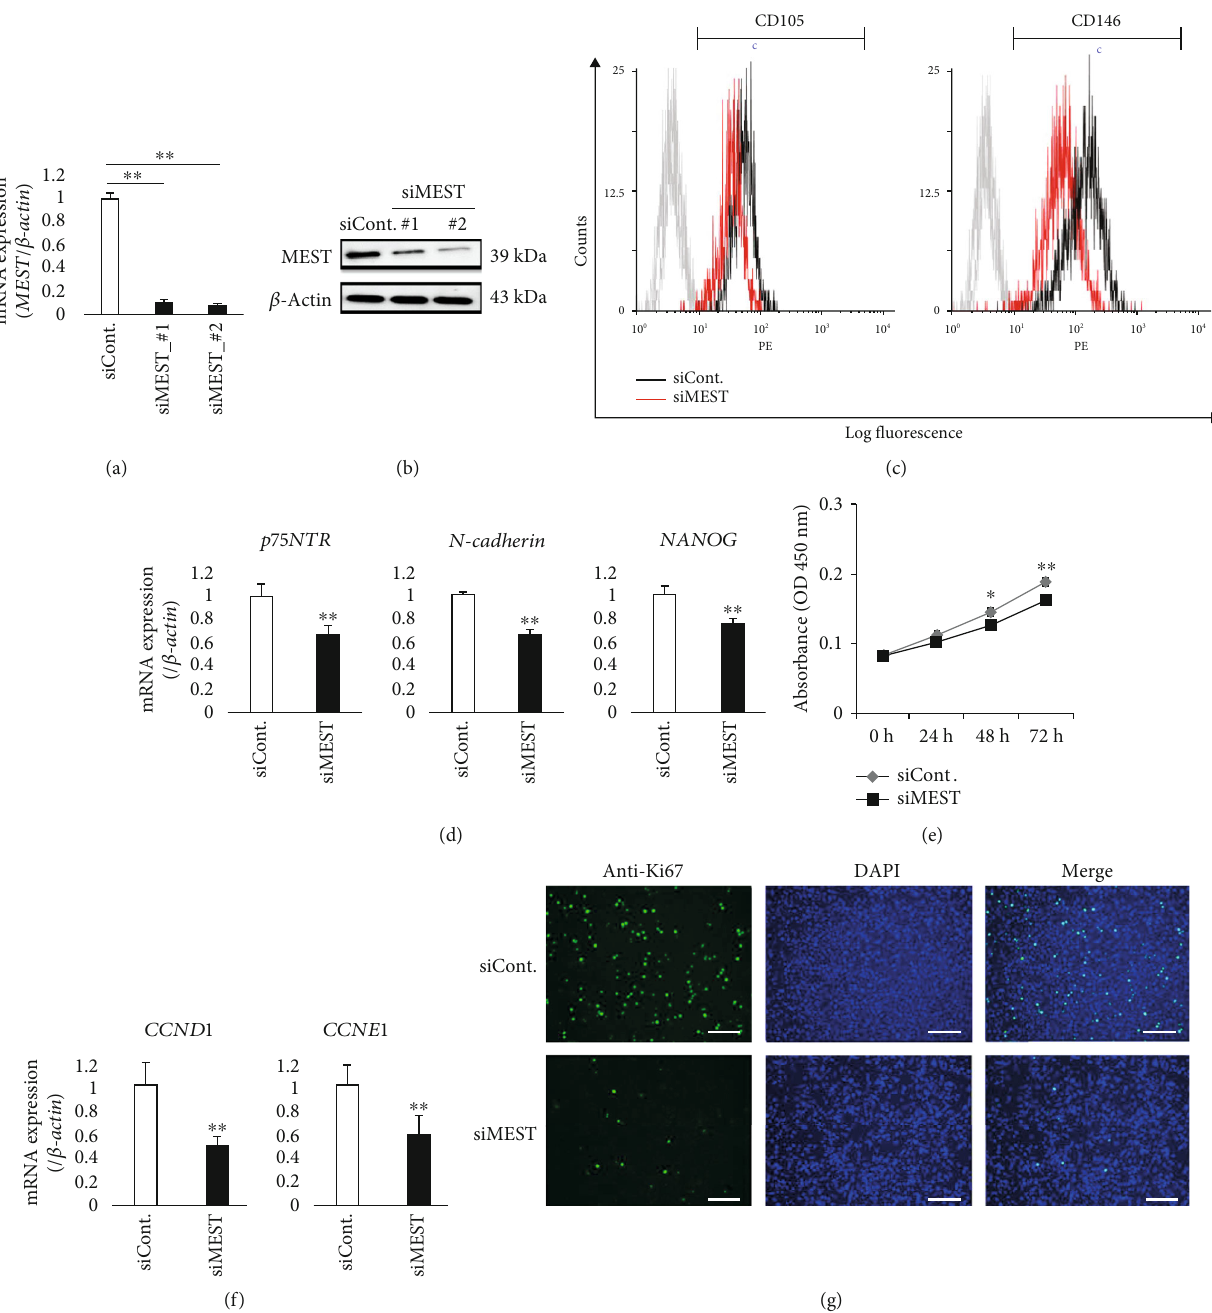
Figure 3: The e ff ects of MEST knockdown on the expression of stem cell markers and the proliferative potential in 2-23 cells. (a, b) The expression of MEST mRNA (a) and protein (b) in 2-23 cells transfected with negative control siRNA (siCont) or MEST siRNA (siMEST_ #1 and siMEST_#2) was assessed by quantitative RT-PCR and western blot analyses, respectively. (c) The expression intensities of CD105 and CD146 in 2-23 cells transfected with siCont. (black line) or siMEST_#1 (red line) were demonstrated by fl ow cytometric analysis. In the gated region, positive cells. (d) The gene expression of p75NTR , N-cadherin , and NANOG in 2-23 cells transfected with siCont. or siMEST was assessed by quantitative RT-PCR. (e) The proliferation of 2-23 cells transfected with negative control siRNA (siCont) or MEST siRNA (siMEST) was examined by WST-1 proliferation assay. The graph shows the time-course of the increase in cell numbers of 2-23 cells transfected with siCont. (grey line) or siMEST (black line). All values are means ± S : D : (error bars) of quadruplicate assays. ∗∗ p < 0 : 01 , ∗ p < 0 : 05 . (f) The gene expression of Cyclin D1 ( CCND1 ) and Cyclin E1 ( CCNE1 ) in 2-23 cells transfected with siCont. or siMEST was assessed by quantitative RT-PCR. (f) The expression of Ki-67 in 2-23 cells transfected with siCont. (upper) or siMEST (lower) was observed by immunocyto fl uorescence staining (anti-Ki-67: green, DAPI: blue; bars: 500 μ m). (a, d, f) In quantitative RT-PCR, the expression levels of these genes were normalized against β -actin expression. All values are means ± S : D : (error bars) of quadruplicate assays. ∗∗ p < 0 : 01 , ∗ p < 0 : 05